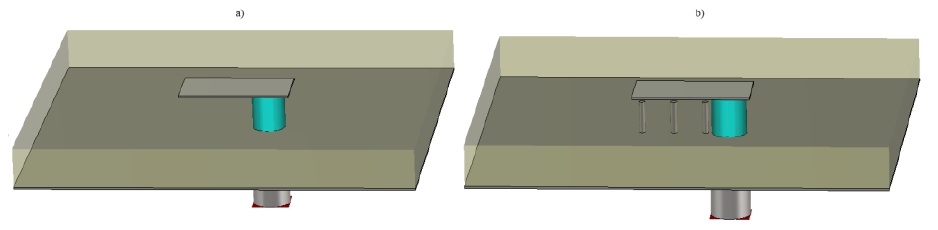
Fig. 1. Models of printed emitters without spikes (a) and with spikes (b).